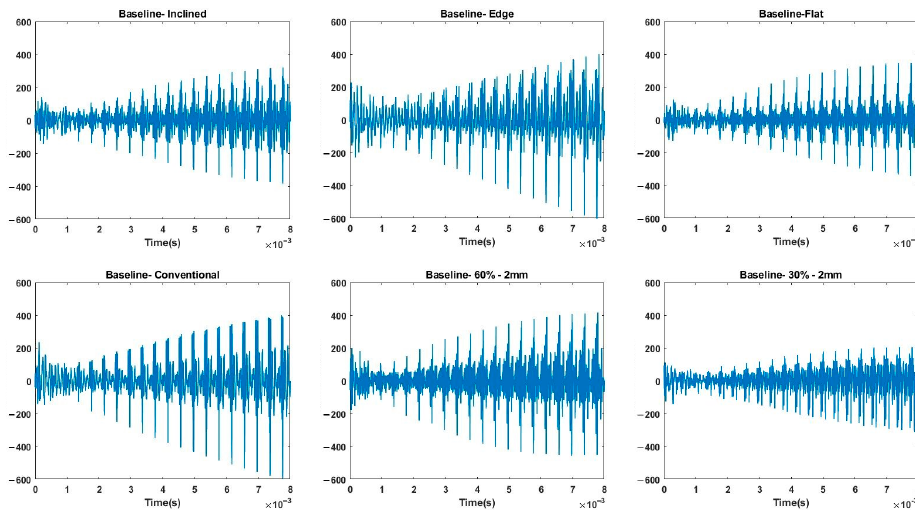
Figure 6. Time domain response to MWPE excitation.